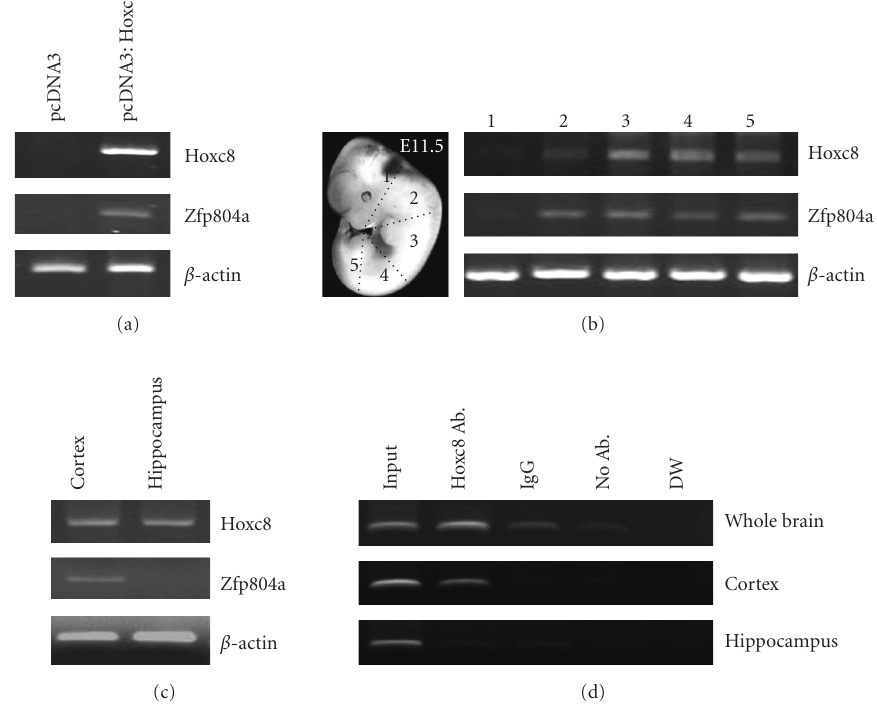
Figure 3: RT-PCR analysis of the Zfp804a gene expression in vitro and in vivo. Total cellular RNA was isolated (a) in vitro with F9 cells transfected with pcDNA3 vector (control) and Hoxc8 overexpression vector and (b) in vivo, from mouse E11.5 embryos. (c) Total cellular RNA was isolated from mouse adult whole brain, cortex, and hippocampus (males, 6 weeks old). (d) A ChIP experiment was performed using mouse adult whole brain, cortex, and hippocampus. The DNA-Hoxc8 complexes were immunoprecipitated by a Hoxc8 monoclonal antibody (lane 2). Input (prior to immunoprecipitation) was used for an internal control (lane 1), and mouse IgG and vehicle were used as a negative control (lane 3-4) and DW (lane